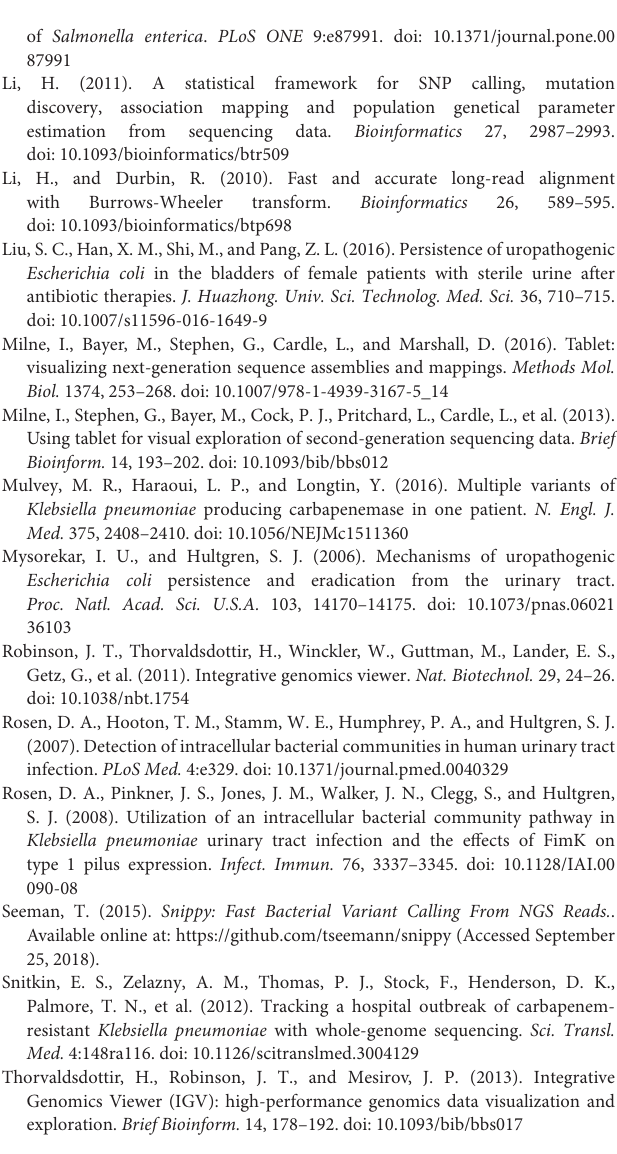
Supplemental Table 3 | Example commands for TOP52 U1 isolate. Illumina FASTQ files are aligned to our PacBio-derived TOP52 U1 assembly, mapped reads are sorted by coordinate position and indexed, duplicate alignments are marked/ignored, single nucleotide variants and small indels are called, and mapping coverage depth is